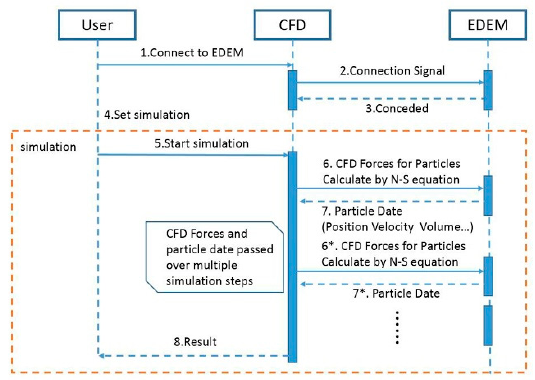
Figure 4. The algorithm of computational fluid dynamics (CFD)-discrete element method (DEM).